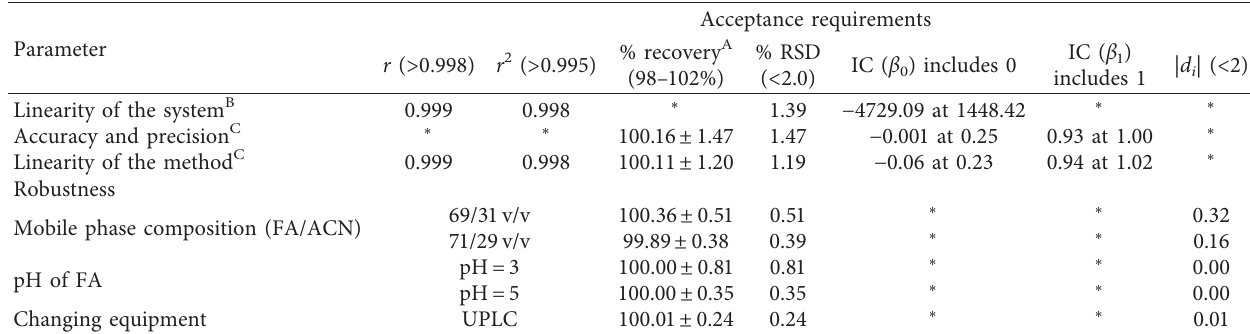
Figure 2: Chromatogram of trans-/cis- resveratrol. The following were obtained from the final working conditions: 10 mM acetonitrile/ ammonium formate mobile phase (pH � 4), 30/70 v/v, at a flow of 0.9ml/min; t-RSV at a t R of 2.6 min (peak “ A ”); and c-RSV at a t R of 3.9min (peak “ B ”), with Symmetry C18 column. Table 1: Summary of validation parameters of